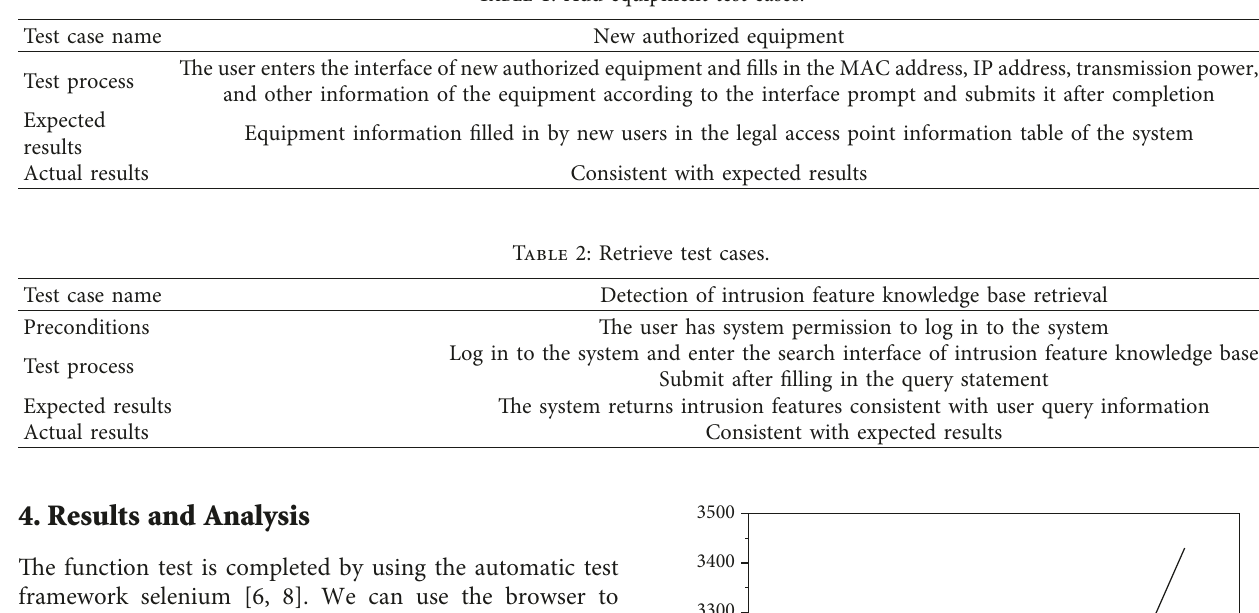
Table 1: Add equipment test cases.